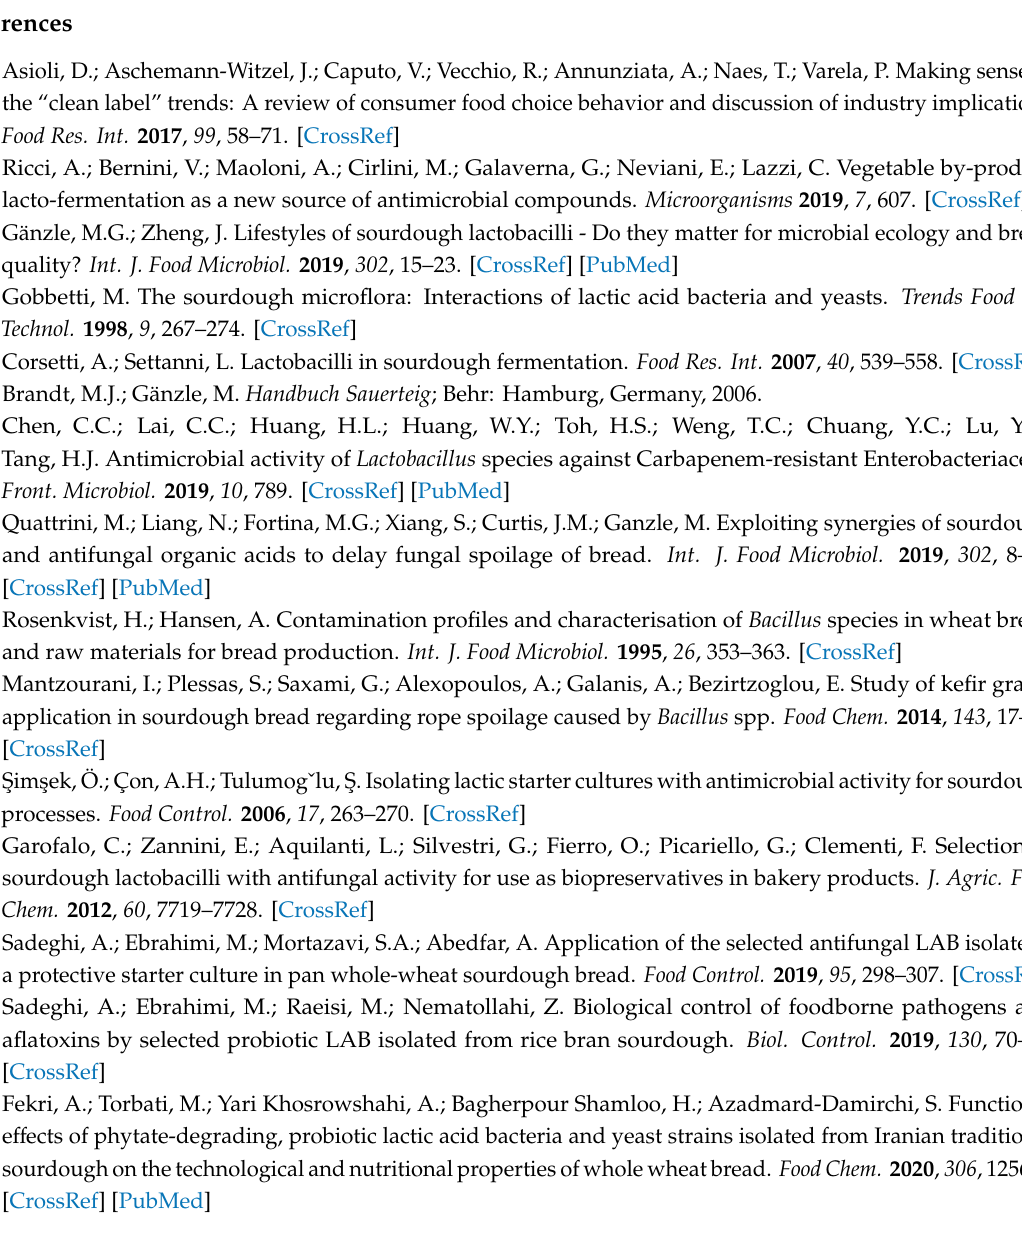
OD 620 measurements; Table S2. LAB isolates used for genomic strain di ff erentiation by the repetitive element PCR; Table S3: Correlation coe ffi cients of growth applying di ff erent carbohydrate sources on the inhibition of fungal